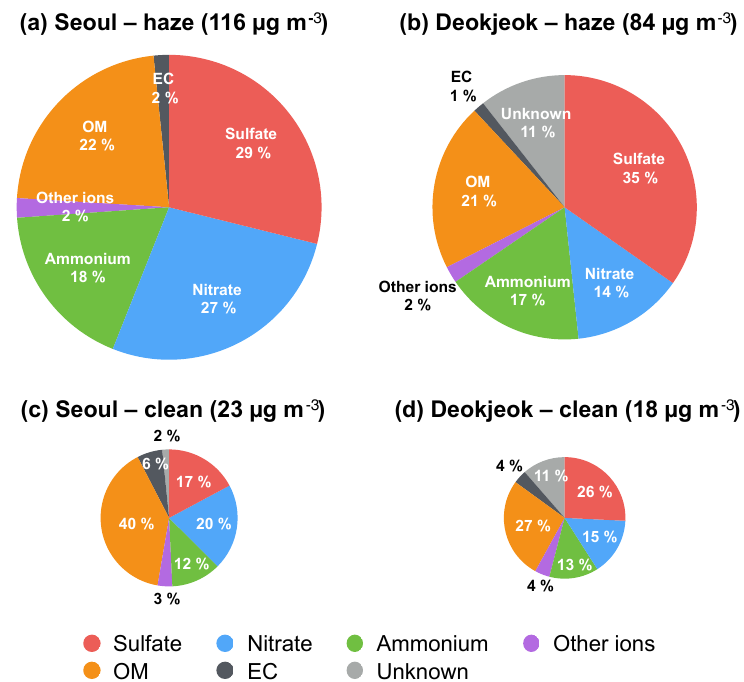
Figure 4. Mass fraction (%) of each component to the total PM 2 . 5 mass in Seoul and Deokjeok during the haze and clean periods. The size of each chart is proportional to the averaged PM 2 . 5 mass concentration. OM is estimated by measured OC and the OM / OC ratios of total identified organic compounds ( ∼ 5% of total